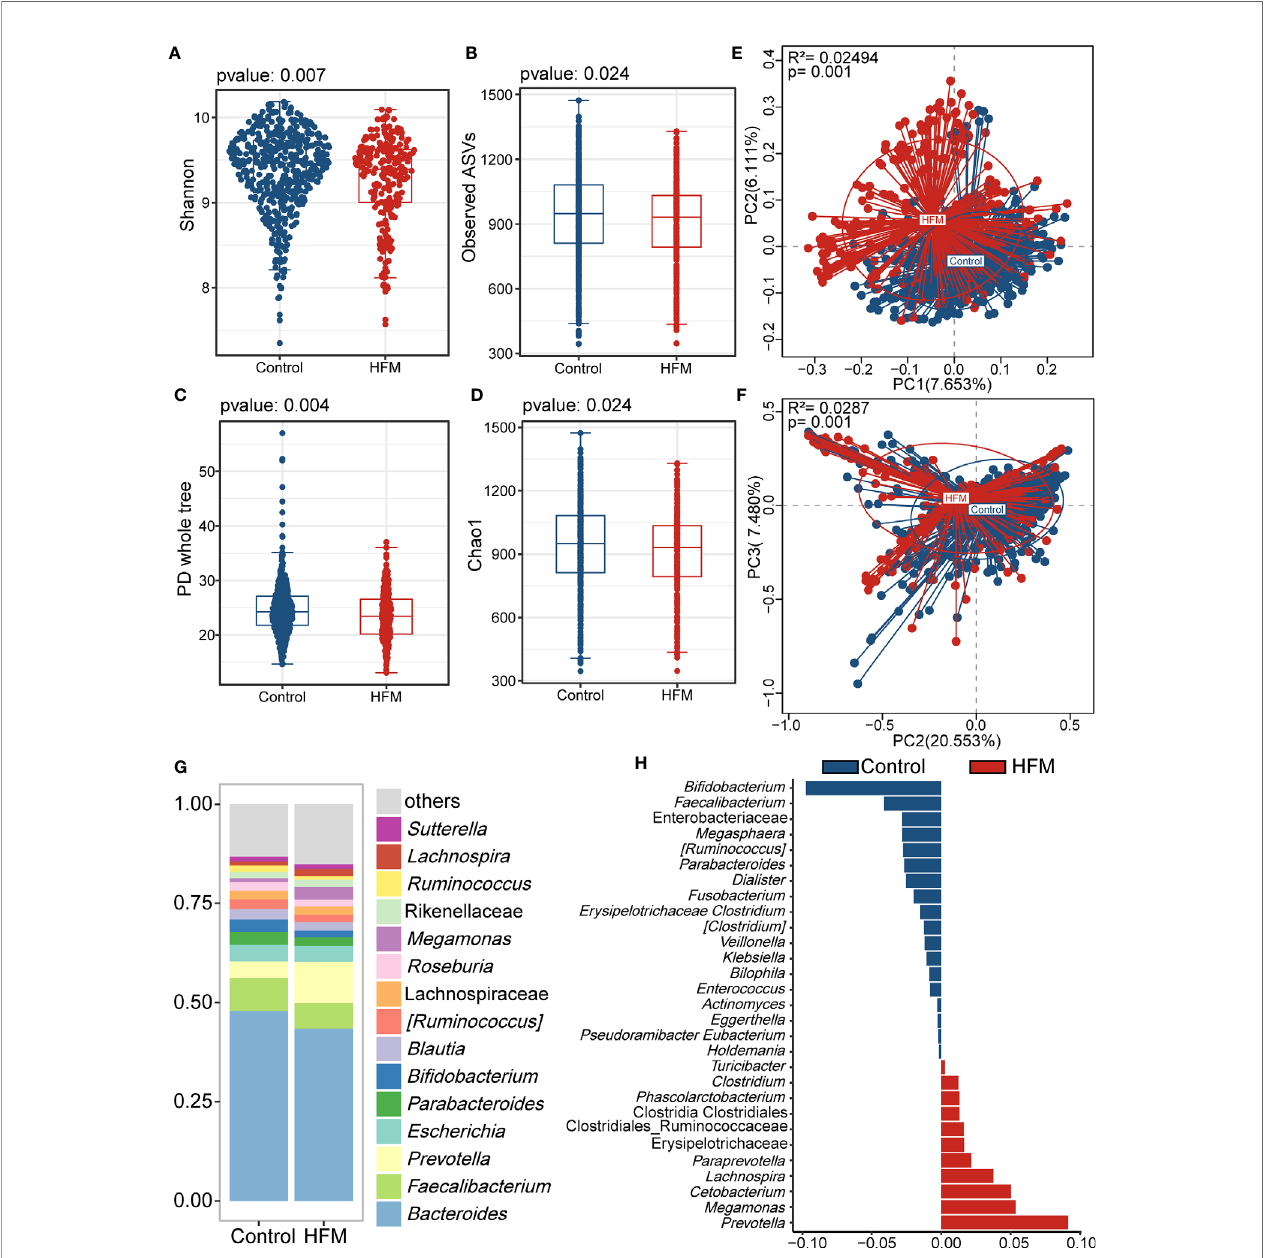
FIGURE 1 | Altered bacterial microbiota biodiversity and composition in HFMD based on whole cohort. (A – D) Alpha diversity. Comparison of alpha-diversity indices (Shannon, observed ASVs, PD whole tree and Chao 1 index) between the male HFMD and male control groups (Wilcoxon rank-sum tests). (E, F) Principal coordinate analysis based on unweighted and unweighted UniFrac distances revealed that the bacterial communities of patients with HFMD clustered separately from the bacterial communities of healthy control children. Each point represents a single sample, which is colored based on the group. PC1, PC2 and PC3 represent the top three principal coordinates that captured most of the diversity. The explanation of diversity captured by the coordinate is given as a percentage. (G) Relative abundance of the microbiota at genus level. (H) Differences in the bacterial taxon between patients with HMFD and control children. The beta coef fi cient was calculated with the multivariate association with linear models 2 (MaAsLin2) after adjusting for age and